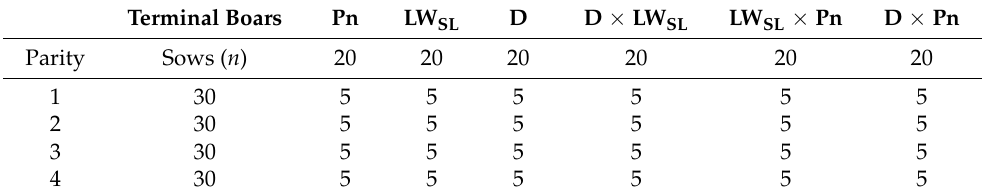
Table 1. Distribution of animals for analysis of reproductive parameters of sows and losses of piglets.